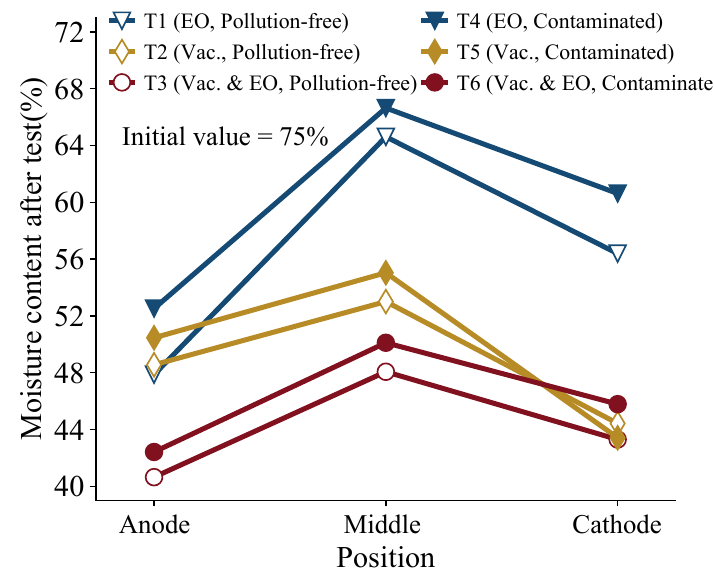
Figure 5. Distribution law of soil moisture